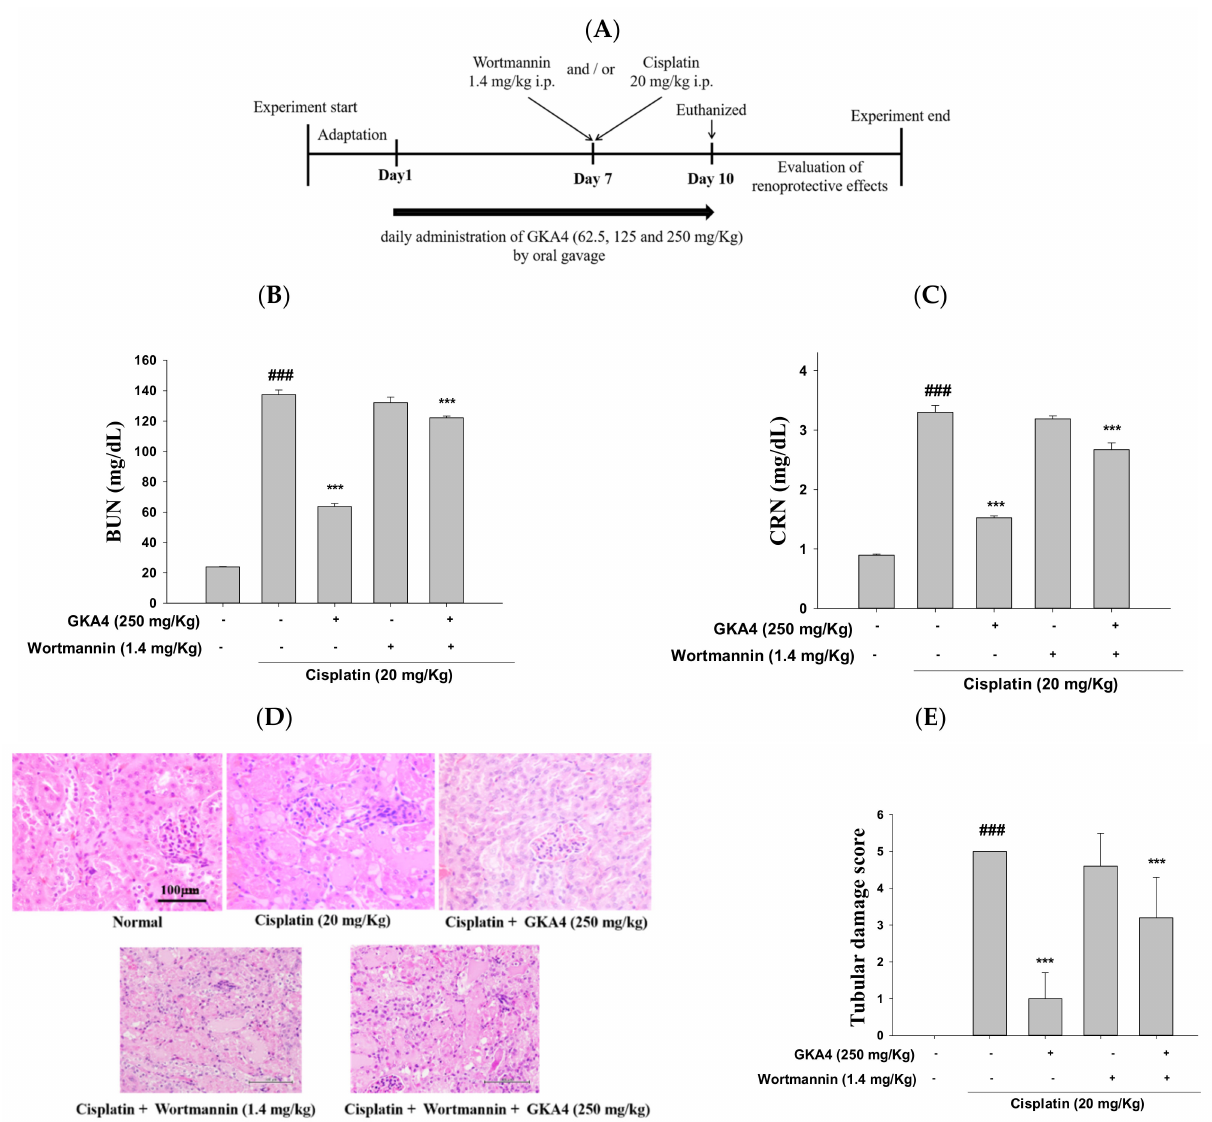
Figure 8. Effects of GKA4 and the PI3K inhibitor (wortmannin) after cisplatin exposure. GKA4 (250 mg/kg) and/or wortmannin (1.4 mg/kg) were given daily for 10 days. Cisplatin (20 mg/kg, i.p.) was administered 1 h after GKA4 and/or wortmannin on day 7, and euthanasia was performed on day 11. The figure shows the design of the experiment ( A ), BUN levels ( B ), CRE levels ( C ), kidneys stained with H&E ( D ), and kidney injury scores ( E ). Histopathologic analysis of kidney tissues using H&E staining and photographed (400 × ). The values were displayed as the means ± S.E.M ( n = 5). The data are presented as the means ± S.E.M ( n = 5). ### denotes p < 0.001 compared with the sample of the control group. *** p < 0.001 compared with the cisplatin